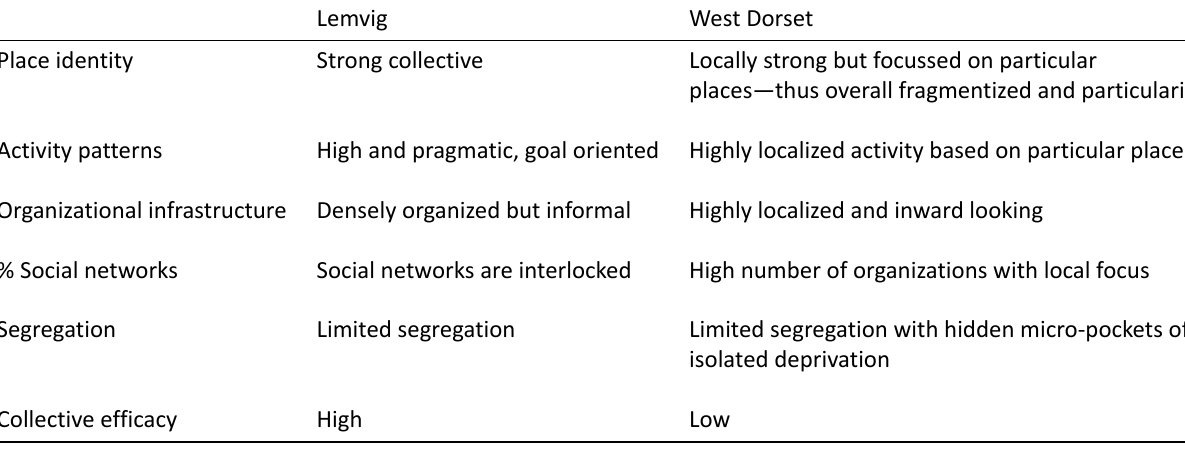
Table 2. Outlining characteristics of collective